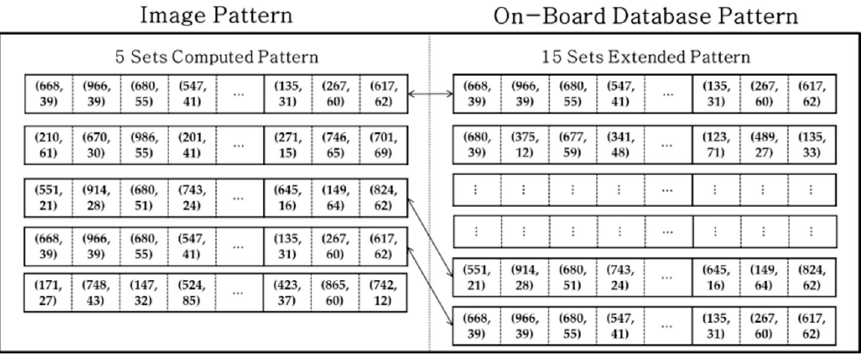
Figure 9. Image and extended database grid pattern for one reference star.